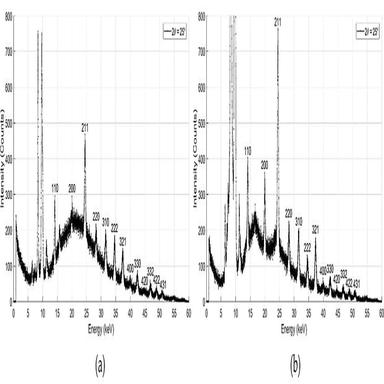
Acquired spectra using a white beam (tungsten anode) after 2 h for (a) GFRP/Steel/GFRP and (b) CFRP/Steel/CFRP hybrid samples.